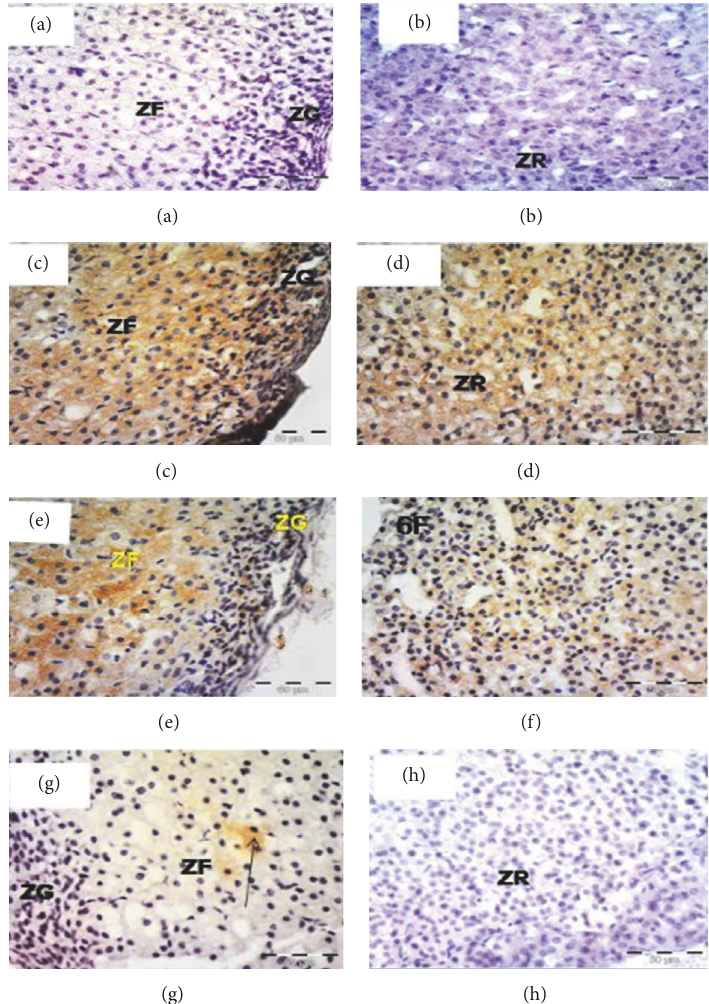
Figure 6: Rat adrenal cortex labeled for caspase-3 of the control group (a and b) showing negative expression; Group II (c and d) showing high expression along the adrenal cortex; Group III showing high expression in ZG and ZR (e) and moderate expression in ZR (f); Group IV (g and h) showing few scattered immunopositive cells among ZF (arrow), × 400. Zona glomerulosa (ZG), zona fasciculata (ZF), and zona reticularis